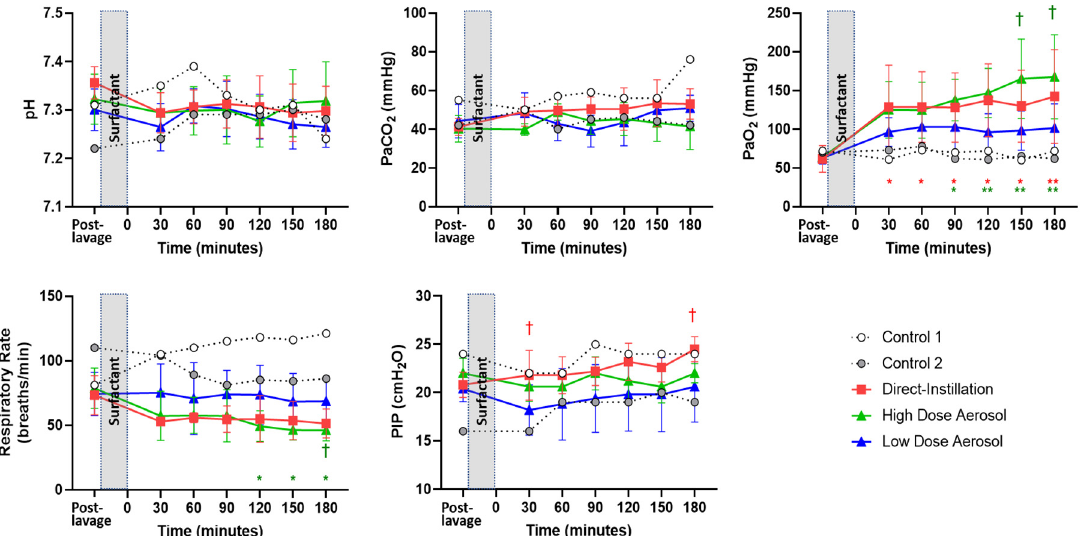
Figure 3. Gas exchange and Ventilation Parameters. Data are represented as individual data for Control and mean ± SD for Surfactant treatment groups during the 180 min treatment period. The post-lavage condition shows animals following lung injury and stabilization and represents the baseline pre-treatment condition and the time at which treatment was instituted. Time point 0 represents timepoint following completion of surfactant administration. The time increments represent values obtained 30 min after completion of treatment and at 30 min intervals thereafter. Controls are shown for descriptive purposes but were underpowered and not included in the statistical analysis. There were no differences in pH or PaCO 2 between treatment groups or within groups between the respective baseline pre-treatment values and at the different timepoints following treatment. There were improvements in PaO 2 in surfactant-treated groups 30 min after treatment, whereas, PaO 2 values remained consistently low (~75) throughout the experiment in the Controls. High Dose Direct-Instillation and Aerosol Groups showed significant improvement in PaO 2 from baseline following surfactant; whereas, Low Dose Aerosol did not. The High Dose Aerosol group had higher PaO 2 than Low Dose Aerosol at at150 and 180 min. PaO 2 did not vary between groups at any other timepoint. The High Dose Aerosol RR was lower at 120, 150, and 180 min when compared to respective baseline and at 180 min when compared to Low Dose Aerosol. PIP was greater with Direct-Instillation than Low Dose Aerosol at 30- and 180 min post surfactant replacement therapy. *, p < 0.05; **, p < 0.01 vs. baseline. †, p < 0.05 vs. Low Dose Aerosol. PaCO2, partial pressure of carbon dioxide in the arterial blood; PaO2, partial pressure of oxygen in the arterial blood; PIP, peak inspiratory pressure.